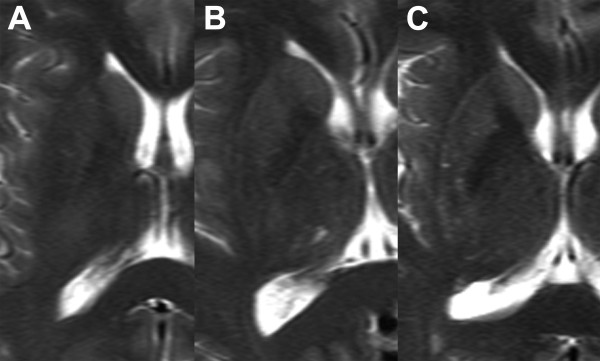
Axial T2-weighted images of normal subjects showing different degrees of conspicuity of HPR. HPR results classified as absent (A), vague (B), and present (C) are shown.